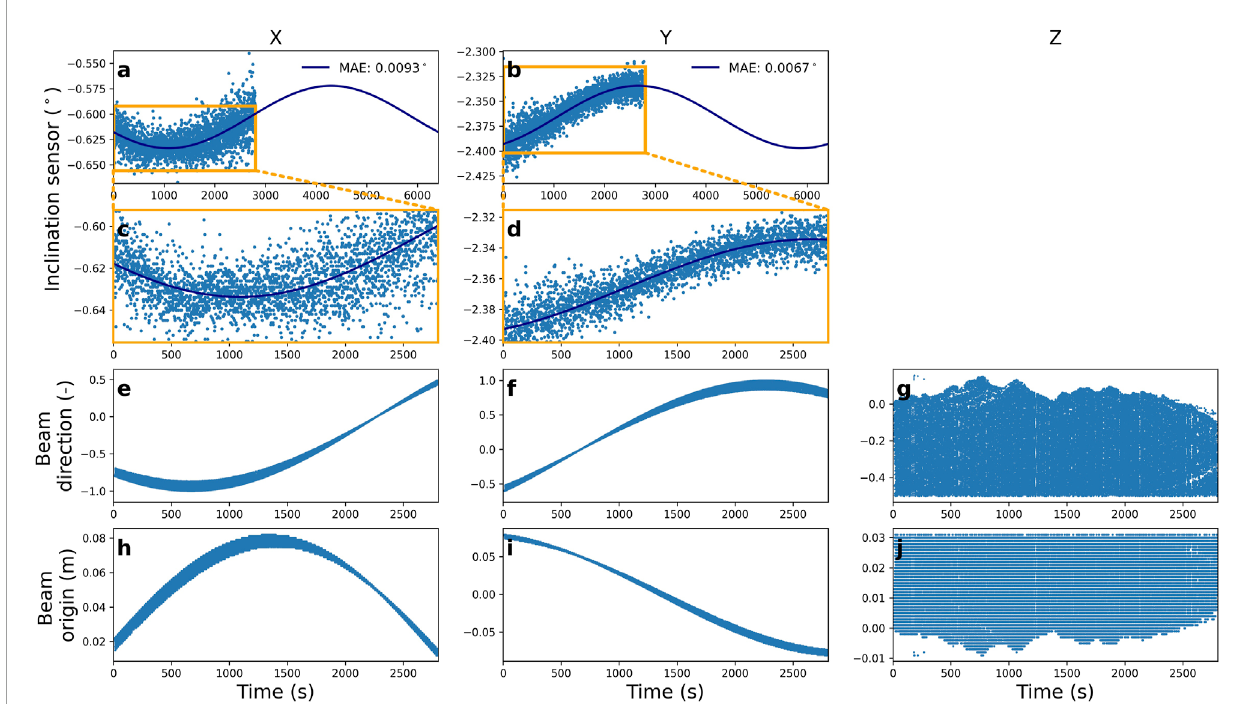
FIGURE 3 (A) Roll measurement with its calculated trend through the data, (B) pitch measurement with its calculated trend through the data, (C, D) zoomed area of the orange boxes in (A, B) , respectively, (E–G) beam direction, and (H–J) beam origin as read from the raw data sampled at every 1000th point. The mean absolute error (MAE) of the trend through the roll and pitch data is given in (A, B) .